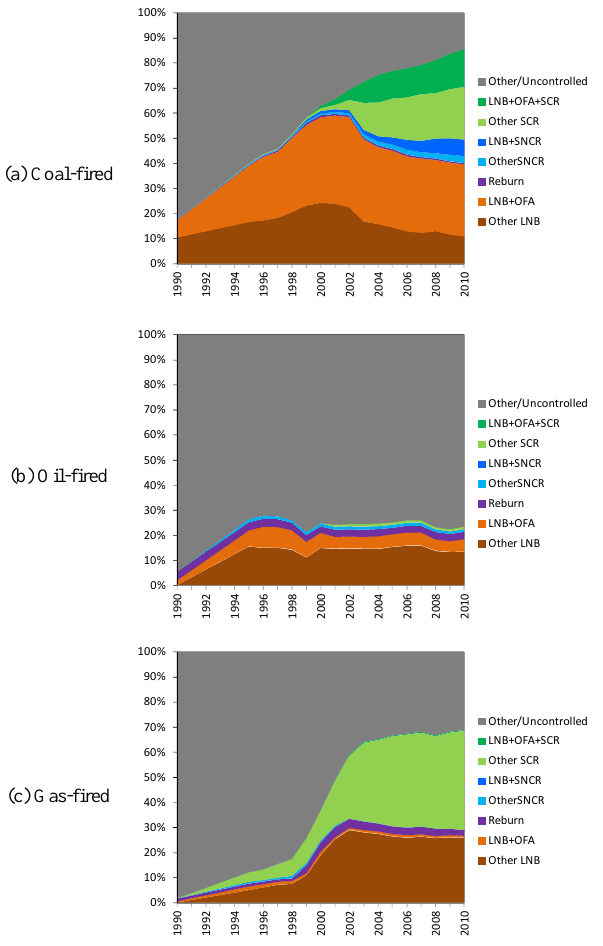
Fig. 2. Application of NO x control technologies in power plants from 1990 to 2010 by primary fuel type (weighted by unit capacity, LNB – low NO x burners; OFA – overfire air; SNCR – selective non-catalytic reduction; SCR – selective catalytic reduction; based on the Clean Air Markets data,